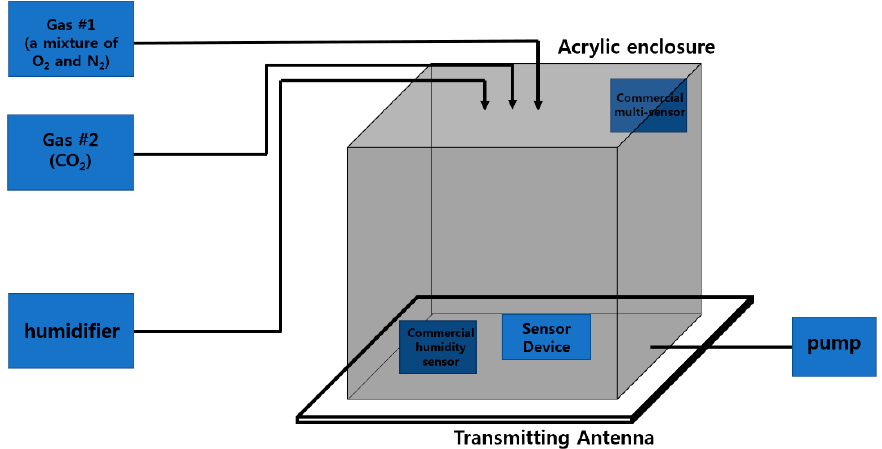
Figure A6 . Schematic illustration of experimental setup for sensing of RH.